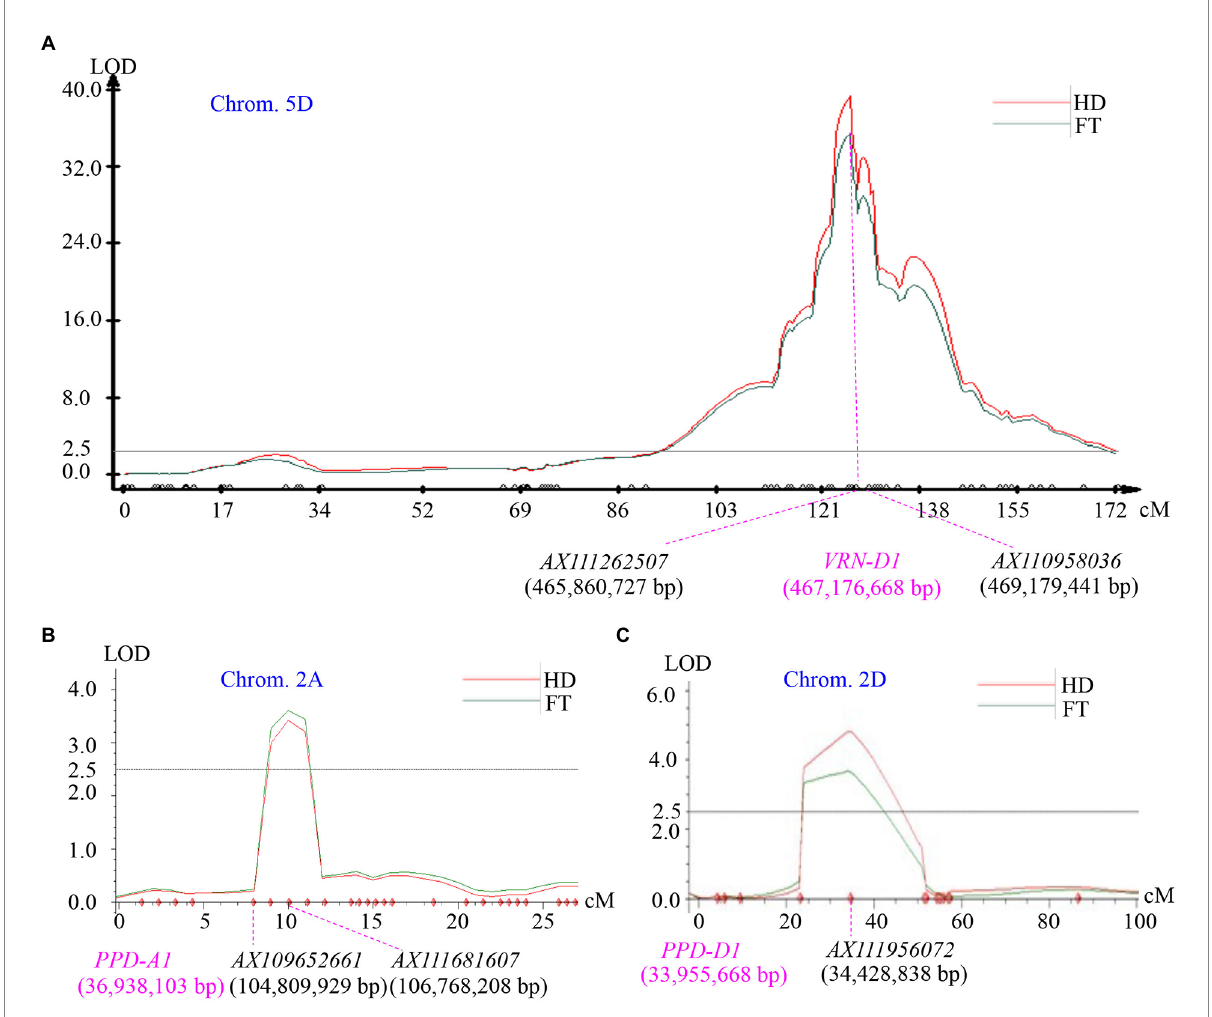
FIGURE 2 Mapping of quantitative trait loci (QTLs) for heading date segregated in the Tabasco and Zi119 population. (A) A major QTL on chromosome 5D. The peak of this QTL is associated with the VRN-D1 gene. (B) A minor QTL on chromosome 2A. The peak of this QTL is not associated with the PPD-A1 gene. (C) A minor QTL on chromosome 2D. The peak of this QTL is associated with the PPD-D1 gene. The phenotypic data was for heading date (HD) or flowering time (FT). LOD value is indicated on Y axis, and genetic distance (cM) is indicated on X axis. The physical locations of the genes are indicated in pink based on the Chinese Spring genome sequence of RefSeq